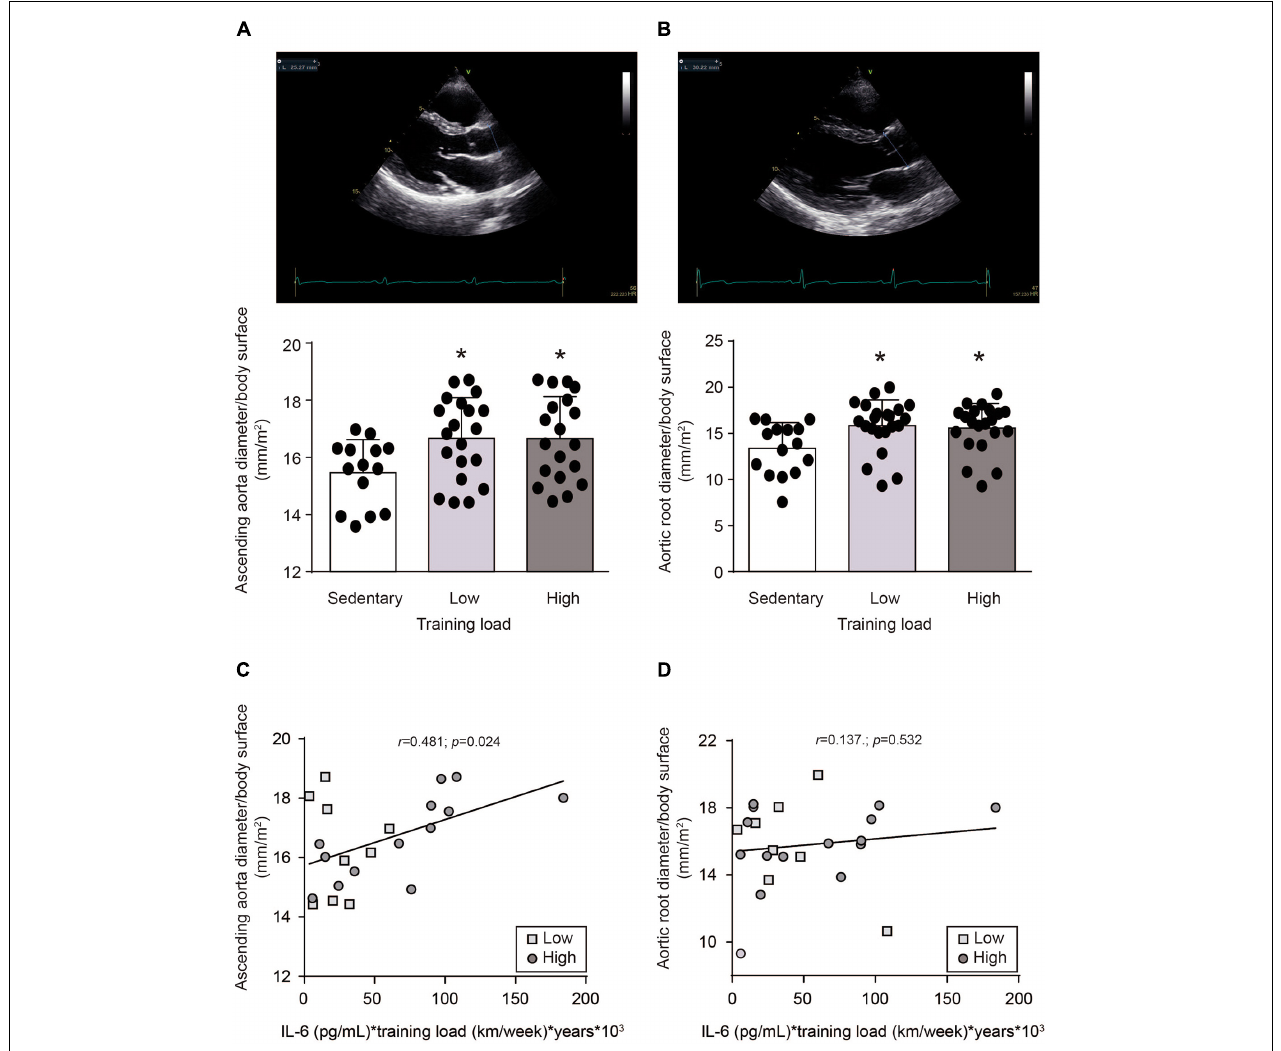
FIGURE 3 | Aortic diameter in in sedentary subjects and athletes with high and low training loads. HT-group: ≥ 100 km by week, n = 19; LT group: < 100 km by week, n = 20; and a healthy and inactive physically group (control, CT; n = 14). (A) Ascending aortic and (B) aortic root diameters were determined by transthoracic echocardiography and normalized by body surface. Upper panels are representative images of the echocardiography. Lower panels are the quantifications. Data are mean ± SD. Data were analyzed by one-way ANOVA followed by Holm-Sidak’s multiple comparisons test. * p < 0.05 vs. sedentary group. Correlation between (C) ascending aortic or (D) aortic root diameters with plasma IL-6 levels, were evaluated by Pearson’s analysis. Plasma IL-6 levels, determined immediately after running the marathon, were multiplied by training load -considered as kilometers ran per week-, and years of training ( (cid:3) ) HT group: ( (cid:13) ) LT